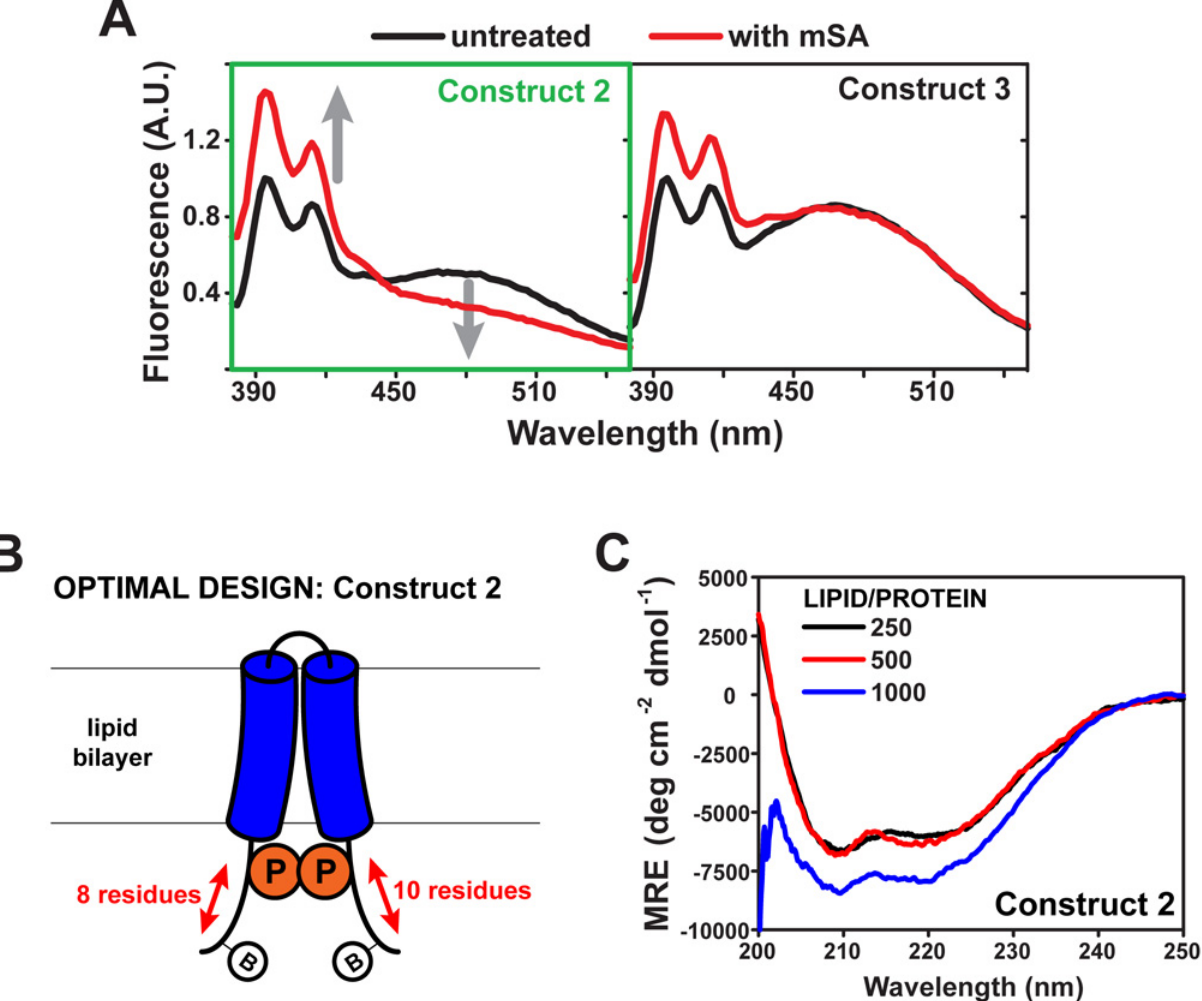
Fig 4. Assay for an optimal TM3/4 unfolding platform. ( A ) Pyrene fluorescence spectra in the absence or presence of 20 μ M S45A mSA for two TM3/4 constructs designed, expressed, purified, and reconstituted in POPC bilayers (lipid/protein = 2000), 50 mM sodium phosphate pH 7.5, and 200 mM NaCl. Peaks between 380 – 440 nm are due to emission of monomeric pyrene while the broad peak centered around 480 nm is indicative of pyrene excimers, and thus of proximity of the two pyrene labels. Upon addition of mSA, construct 2 (highlighted in green) exhibits a drop in excimer peak with a concomitant increase in monomer intensity. ( B ) Schematic of the optimal construct selected for the unfolding platform. Biotin tags are relatively close to N- and C- terminal pyrene labels, 8 and 10 residues away respectively. ( C ) CD spectra of construct 2 at various lipid/protein ratios in 50 mM sodium phosphate pH 7.5, and 200 mM NaCl. Higher ratios tested did not yield reliable spectra due high light scattering by high lipid concentrations. At all ratios tested, construct 2 is helical. MRE = molar residue ellipticity. CD experiments were performed in